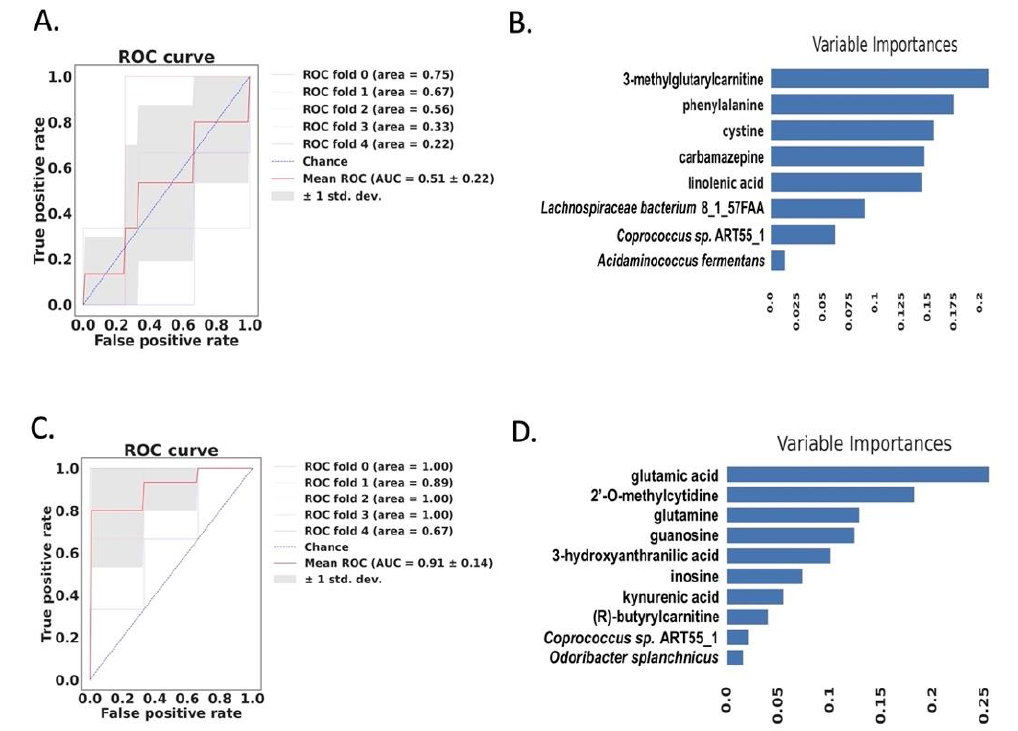
Figure 5. Prediction of progressive liver disease using random forest model. ( A ) Prediction of progressive alcohol-associated liver disease using correlated fecal metabolites and microbial species. ( B ) Variable importance of correlated fecal metabolites and microbial species. ( C ) Prediction of progressive liver disease using correlated serum metabolites and microbial species. ( D ) Variable importance of serum metabolites and microbial species.